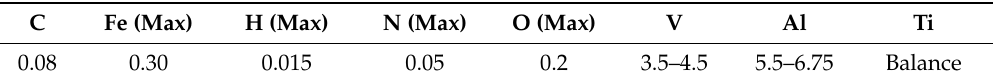
Table 1. Chemical composition of Ti-6Al-4V alloy (wt.%)